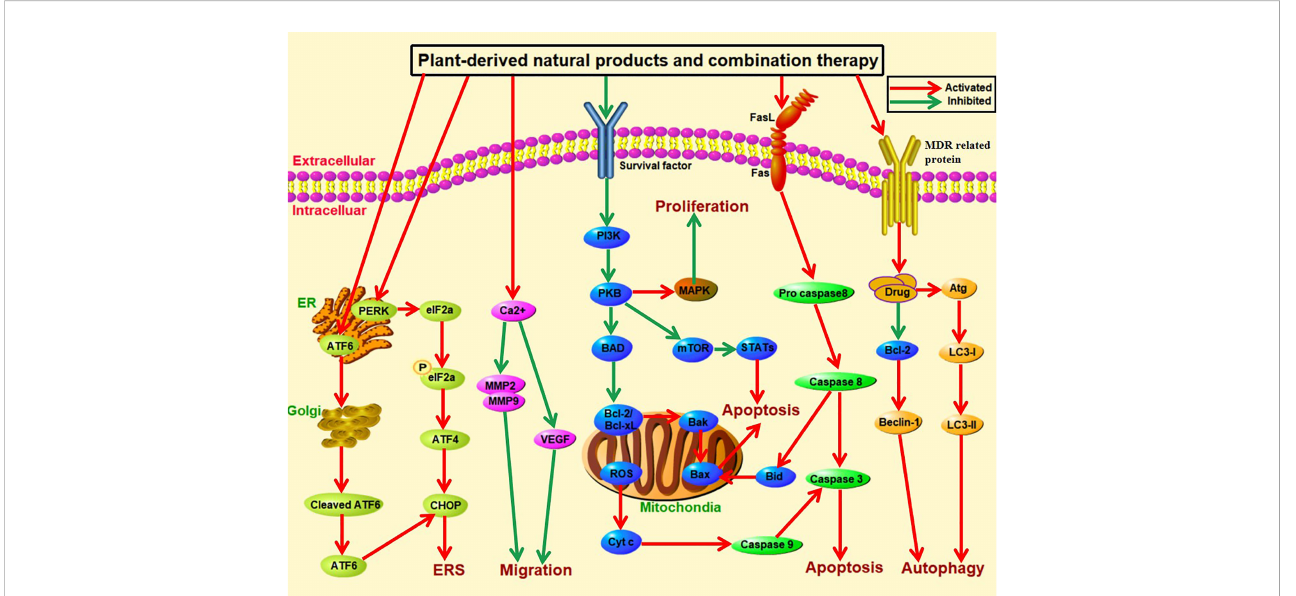
FIGURE 3 Overview of signaling pathways against liver cancer. Plant-derived natural products and different combination therapy can achieve practical anti-liver- cancer effects through multiple mechanisms, including activation of continuing endoplasmic reticulum stress, suppression of migration, inhibition of cell proliferation, induction of apoptosis and autophagy. For example, it could promote apoptosis through the heavy and continuing endoplasmic reticulum stress; and it coula promote the expression of ATF6, PERK, eIF2 a , p-eIF2 a , ATF4, CHOP. It also could suppress migration through increasing the concentration of intracellular calciumions, reduce transcriptional activities of MMP-2 and MMP9 and VEGF to inhibit metastasis. Besides, it could increase the expression of Bcl-x; downregulating the expression of Bcl-xL and Bcl-2; suppressing the PI3K/AKT/mTOR signaling pathway and caspase cascade reaction. In the next place, combination therapy could reduce cancer cell proliferation by binding PI3K and subsequently suppressing PKB function and regulating MAPK signaling pathway. It also coula induce apoptosis through activation of STAT3 via inhibiting the phosphorylation of mTOR. Moreover, it could promote aopotosis through caspase cascade reactor and. In addition, autophagy is also related to occurrence and development of tumor, natural plants target intracellular autophagy including Beclin-1, PI3K/AKT/mTOR, have been known to control cell proliferation and